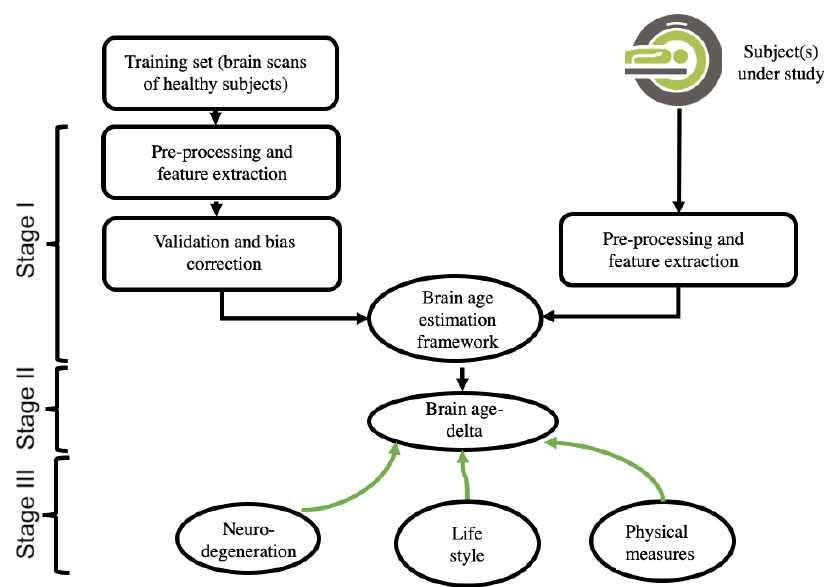
Figure 1. This is a figure. Schemes follow the same formatting.